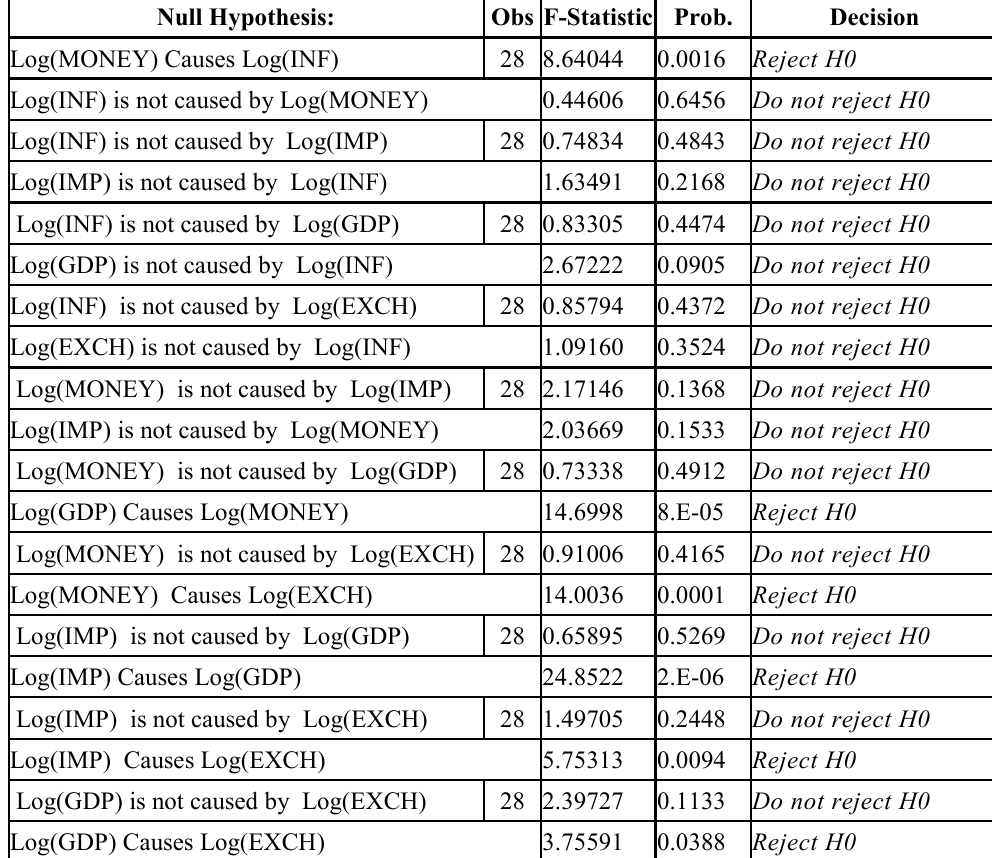
Table 8. Granger Causality Test